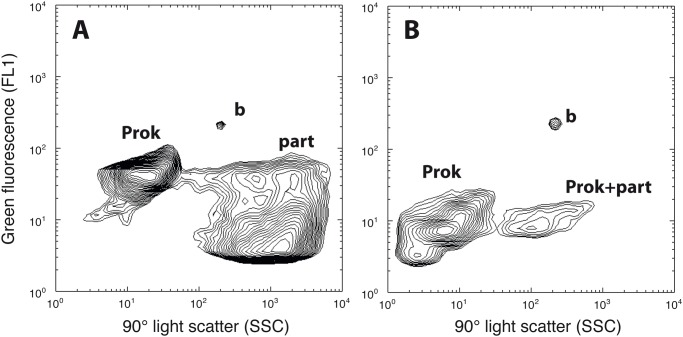
Two examples of Syto13-stained bacterioplankton samples (A: cruise BBC3–St.3, 0 m; B: cruise BBC3–St.17, 70 m) as seen by the flow cytometer in plots of nucleic-acid-based green fluorescence (FL1) versus particle side scatter (a surrogate of particle size).The typical prokaryotic signals (Prok) and the reference beads (b) are accompanied by likely inorganic vent-derived particles (part) and HNA cells likely attached to particles (Prok + part).